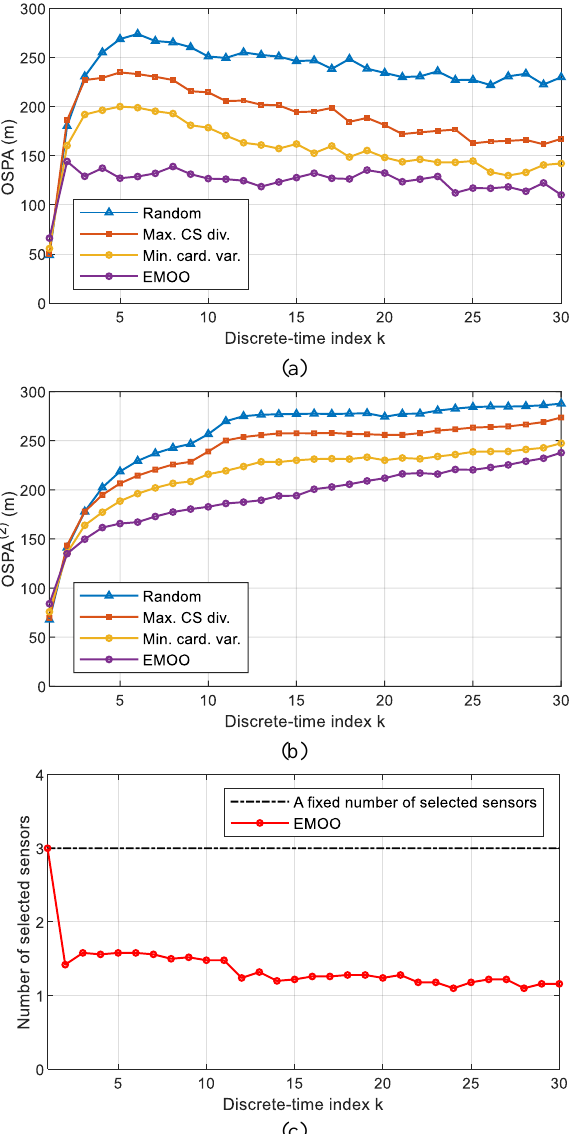
Figure 11. Average performance comparison in Scenario 2: ( a ) OSPA error; ( b ) OSPA ( 2 ) error; ( c ) the number of selected